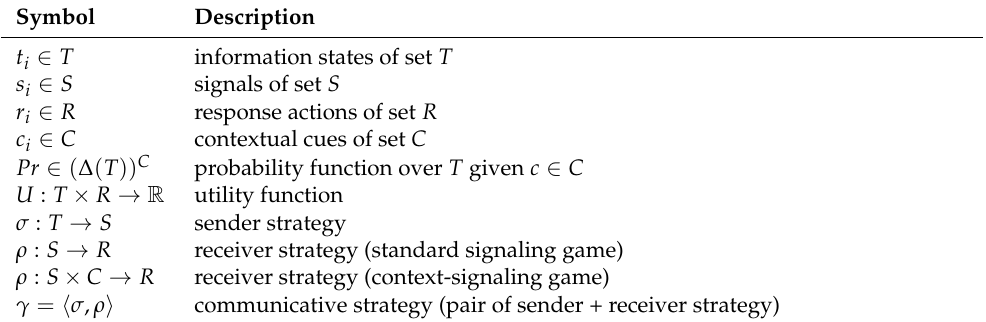
Table 1. Notations for the definition of (context) signaling